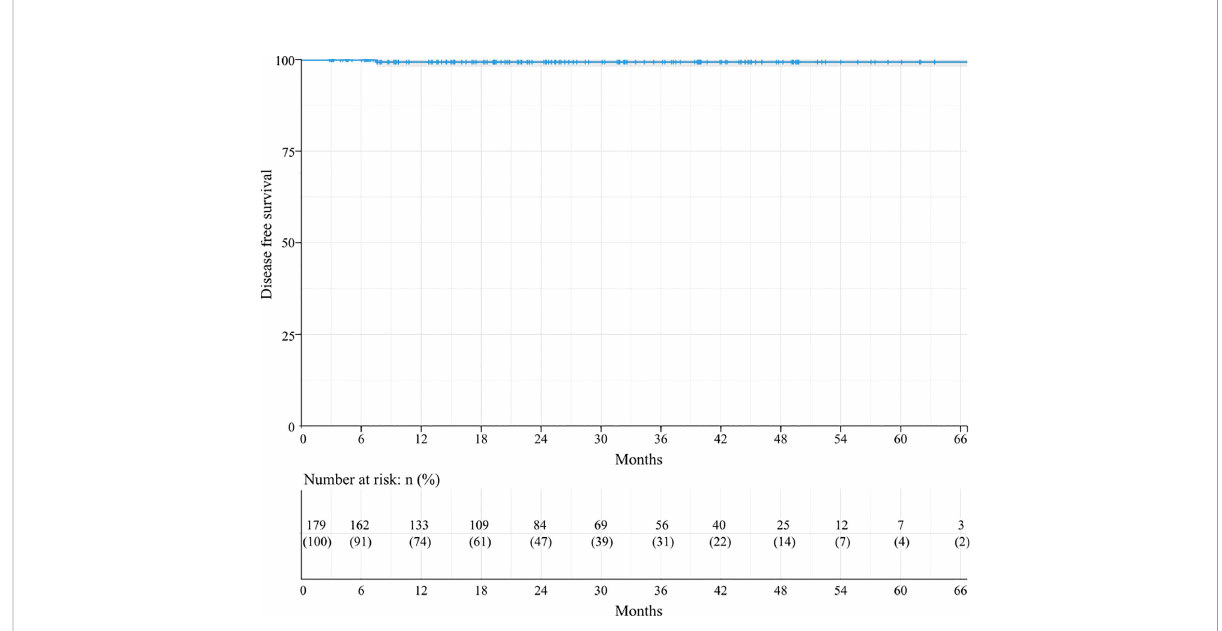
FIGURE 2 Kaplan-Meier survival curve for